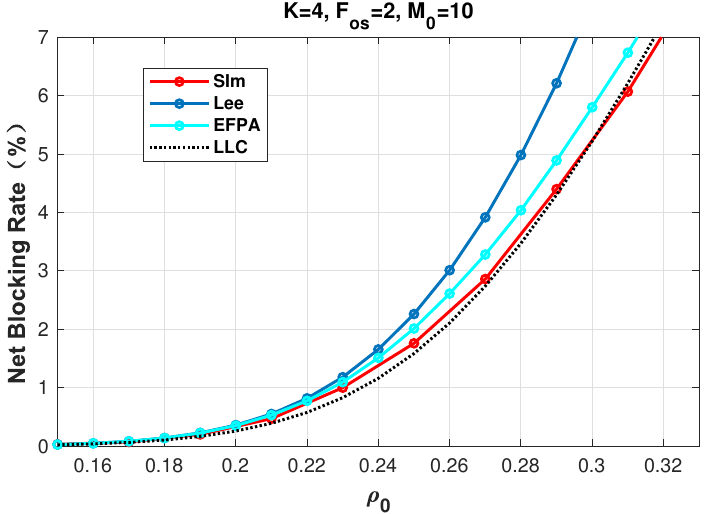
Figure 8. Network blocking performance of different methods with K = 4, F OS = 2, and M 0 = 10.